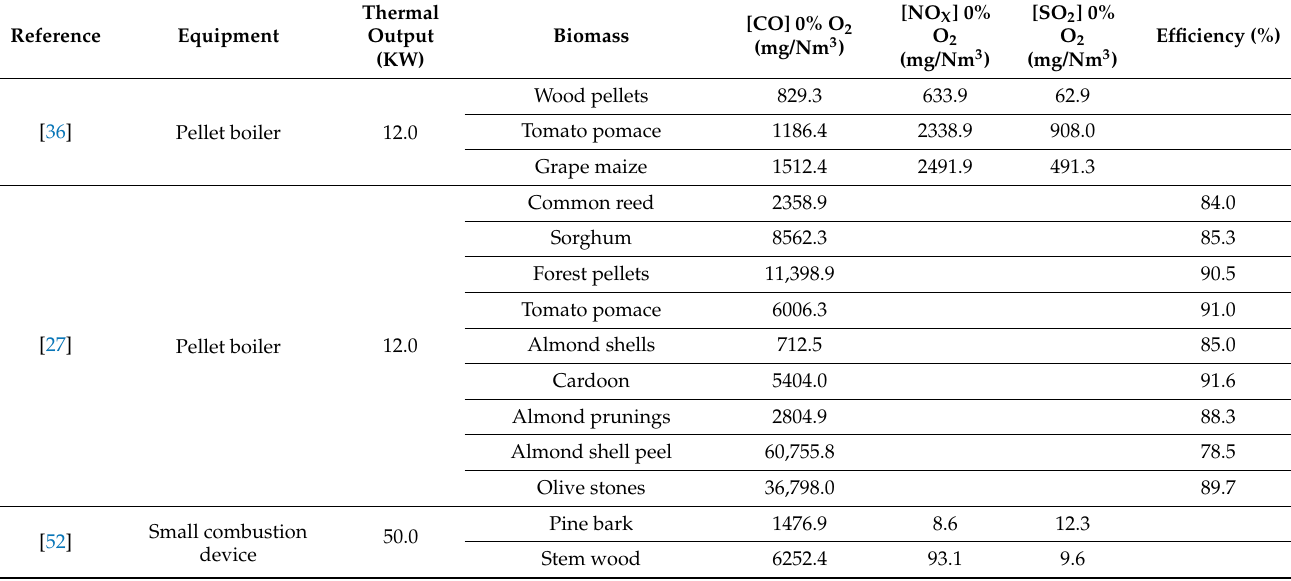
Table A3. CO, NO X , and SO 2 levels, and the thermal efficiency reported in the literature for biomass combustion.